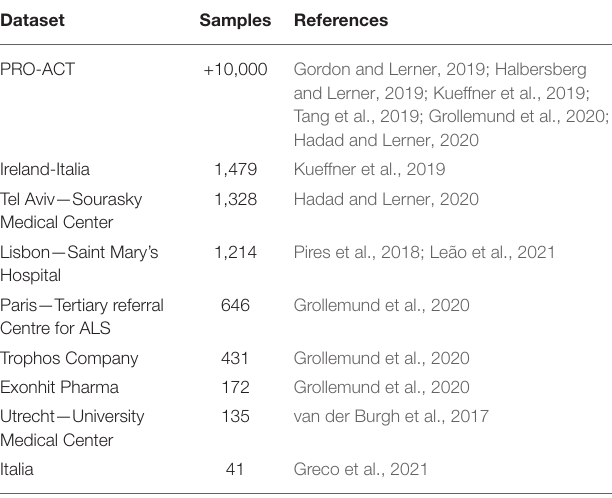
TABLE 4 | List of datasets used in the studies, inversely ordered by the sample size. Dataset